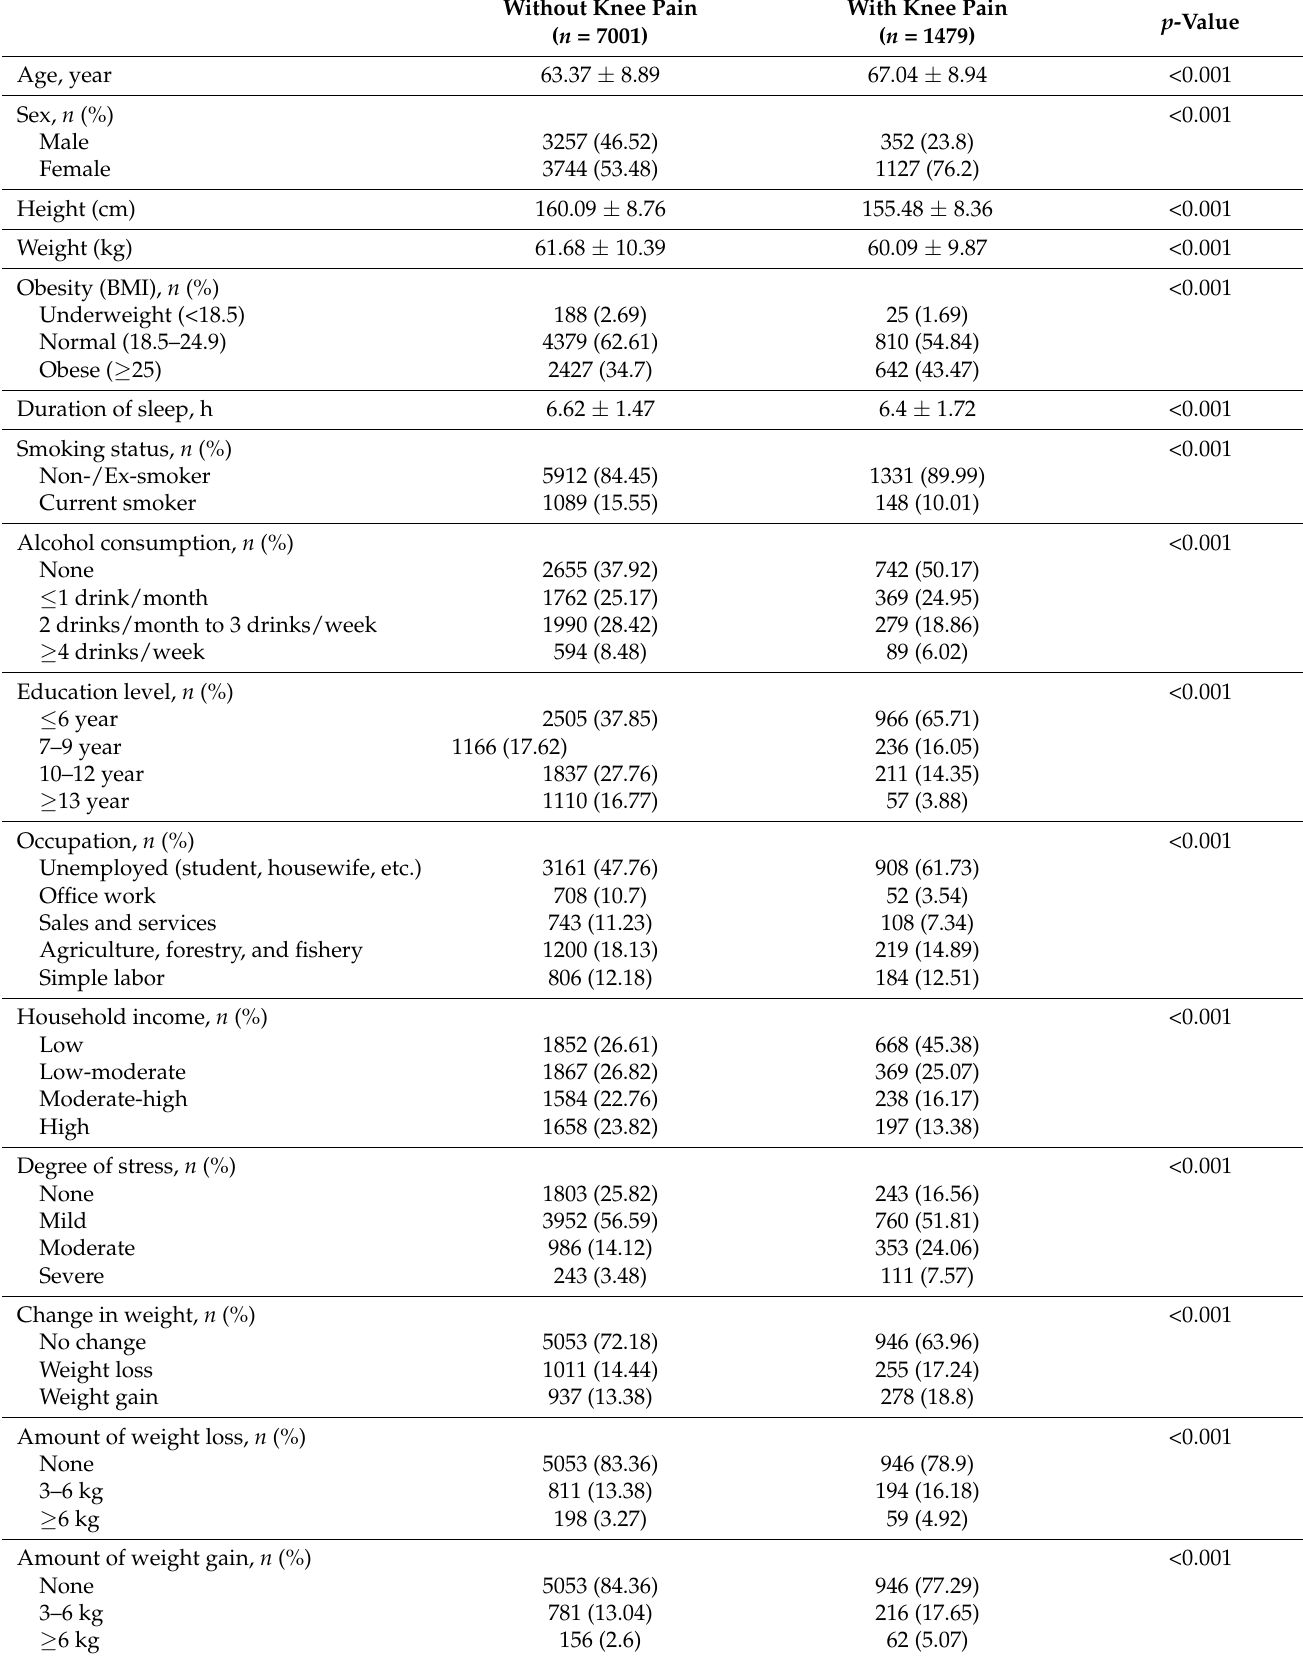
Table 1. General participant characteristics according to knee